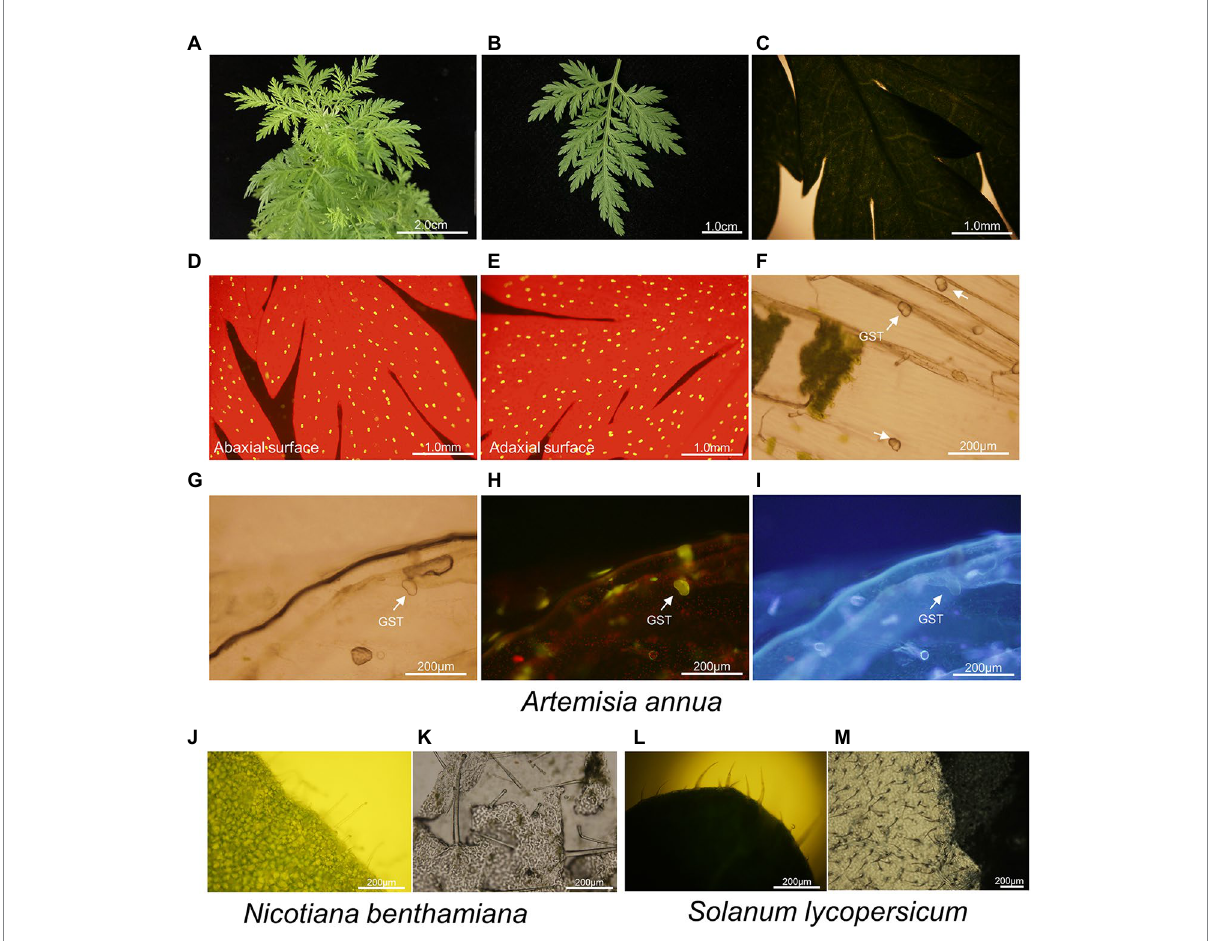
FIGURE 2 Leaf and trichome morphologies of A. annua , N. benthamiana and S. lycopersicum . (A–C) Overview of odd-pinnately compound leaf of 6-month- old A. annua plant; (D–I) Microscopic images of trichomes of A. annua . (D,E) Abaxial leaf surface and adaxial leaf surface were observed under blue light, with red backgrounds representing chlorophyll and yellow spots representing glandular secretory trichomes; Uniseriate epidermis was observed under (F,G) white light, (H) blue light, and (I) UV. Images were taken using a BX-51 microscope (Olympus, Tokyo, Japan). The glandular secretory trichomes were marked with white arrows; (J) Microscopic images of trichomes on the leaf of N. benthamiana ; (K) Microscopic images of uniseriate epidermis of N. benthamiana ; (L) Microscopic images of trichomes on the leaf of S. lycopersicum ; (M) Microscopic images of uniseriate epidermis of S. lycopersicum